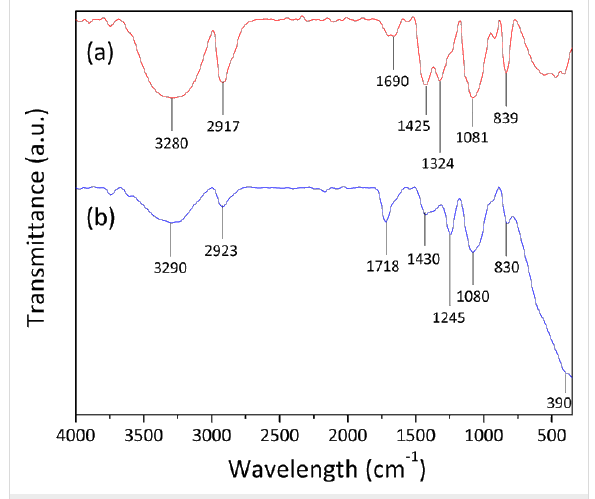
Figure 1: FTIR spectra of (a) PVA (b)